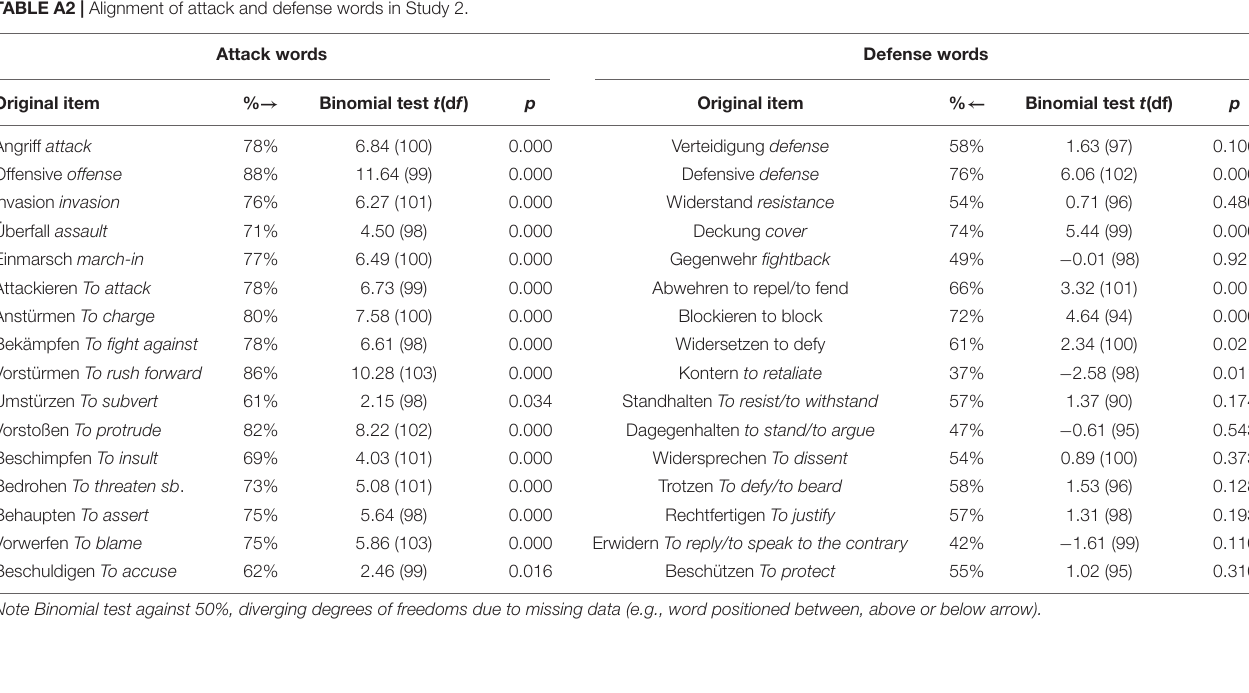
TABLE A2 | Alignment of attack and defense words in Study 2.